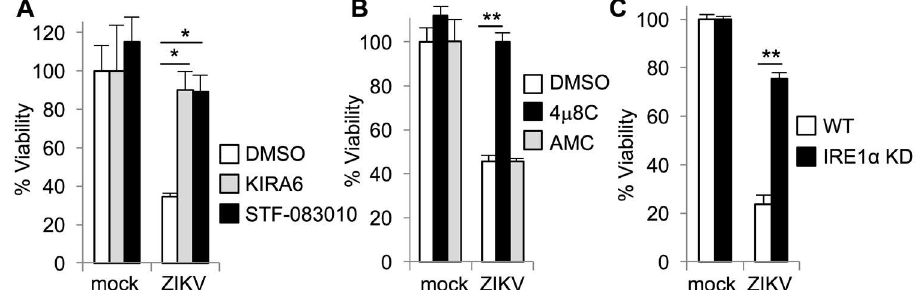
Figure 2. IRE1 α inhibitors prevent ZIKV-induced cell death. ( A + B ) Cells were treated with small molecule inhibitors or DMSO solvent control prior to infection with ZIKV. Viability was measured four days post-infection by quantifying ATP in metabolically active cells. ( A ) The IRE1 α kinase inhibitor KIRA6 and nuclease inhibitor STF-083010 prevent loss of viability during ZIKV infection. ( B ) The IRE1 α nuclease inhibitor 4 µ 8C, but not AMC, a structurally similar negative control compound, prevents ZIKV-induced loss of viability. ( C ) Wildtype (WT) and IRE1 α knockodown (KD) cells were infected with ZIKV and viability was measured three days post-infection. Data are means ± SD of three replicates and are representative of at least two independent experiments. * p < 0.01, ** p < 0.001, by unpaired t